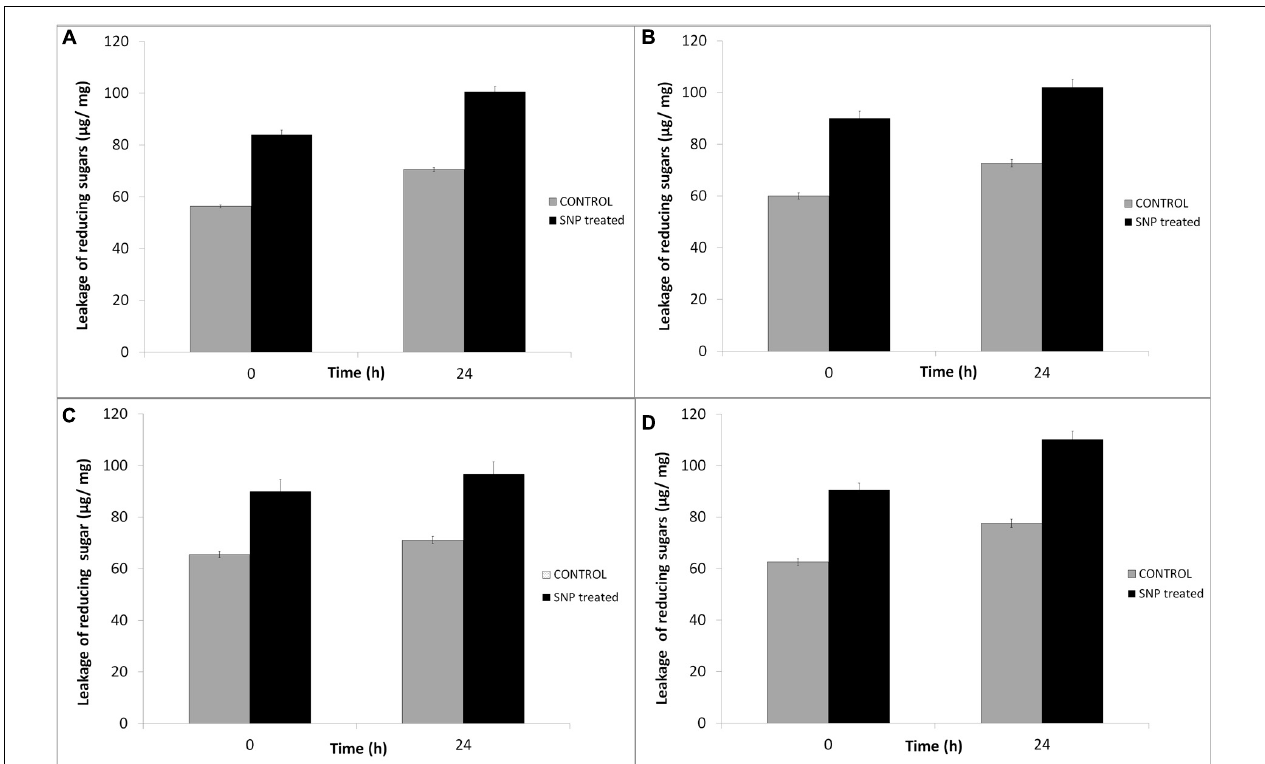
FIGURE 3 | Effect of SNPs on membrane leakage of reducing sugars in haloarchaea (A) Haloarcula argentinensis, (B) Haloarcula tradensis, (C) Haloferax lucentense , and (D) Haloferax prahovense. Error bar represents standard error.